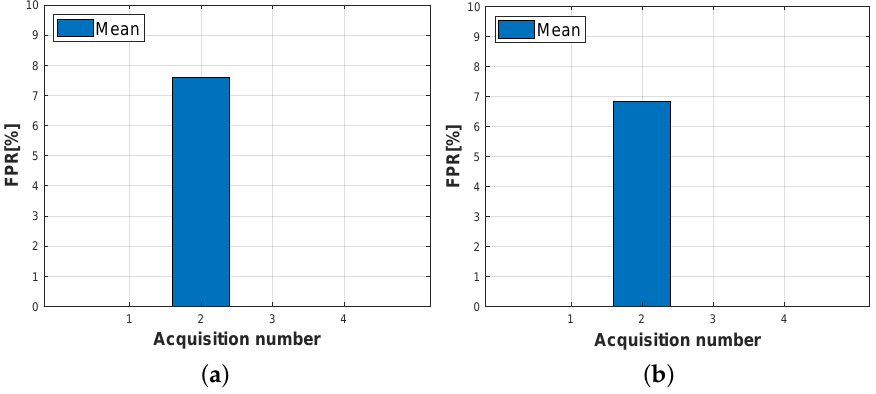
Figure 8. False positive rate (FPR) in the fish freshness example. ( a ) FPR from a leave-one-out test using Bonferroni correction to account for multiple testing. ( b ) FPR from a leave-one-out test and using the Hannig-Marron global rejection